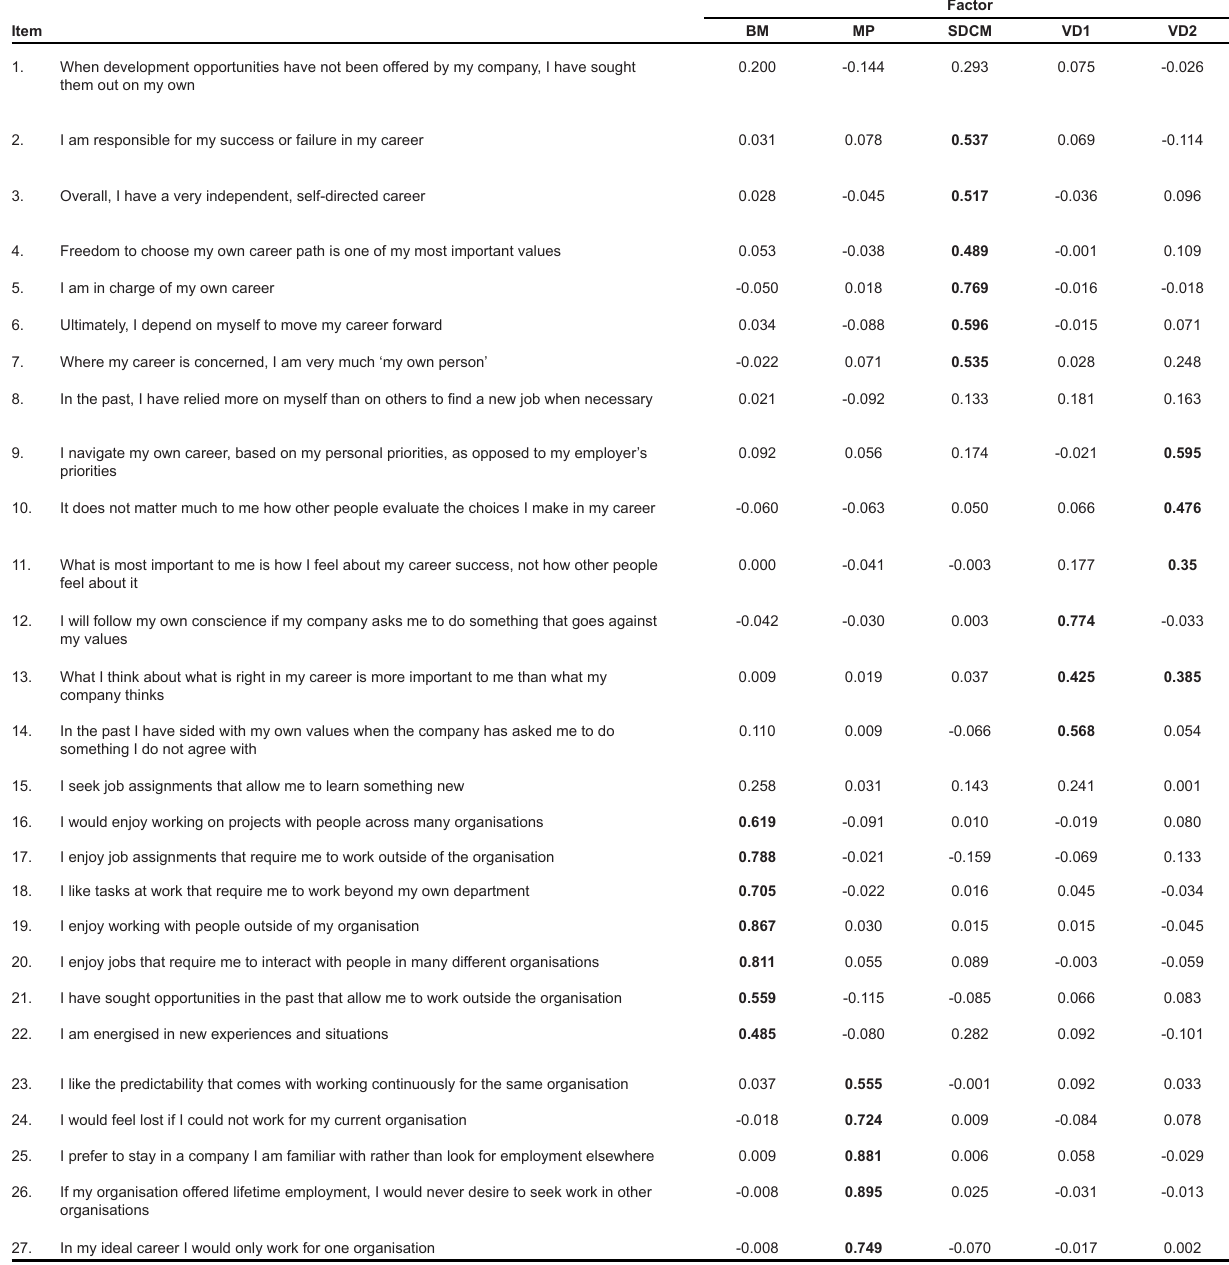
TABLE 2 Oblique Direct Quartimin Rotated Five-Factor Solution